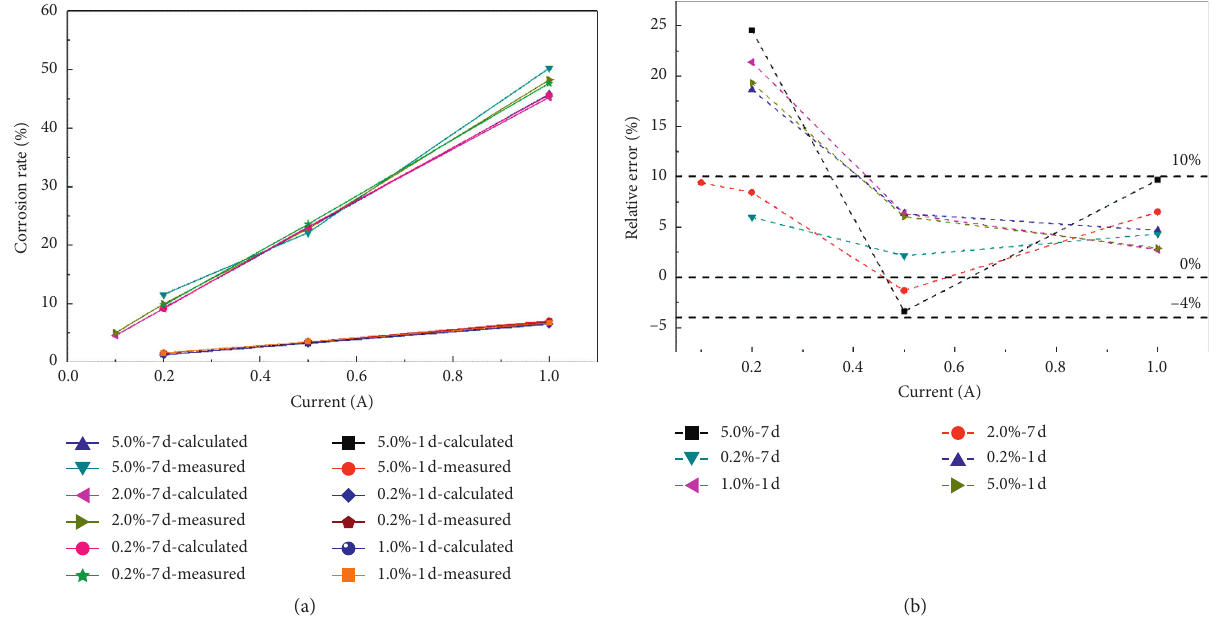
Figure 8: Corrosion rate and RE of anchor samples for different